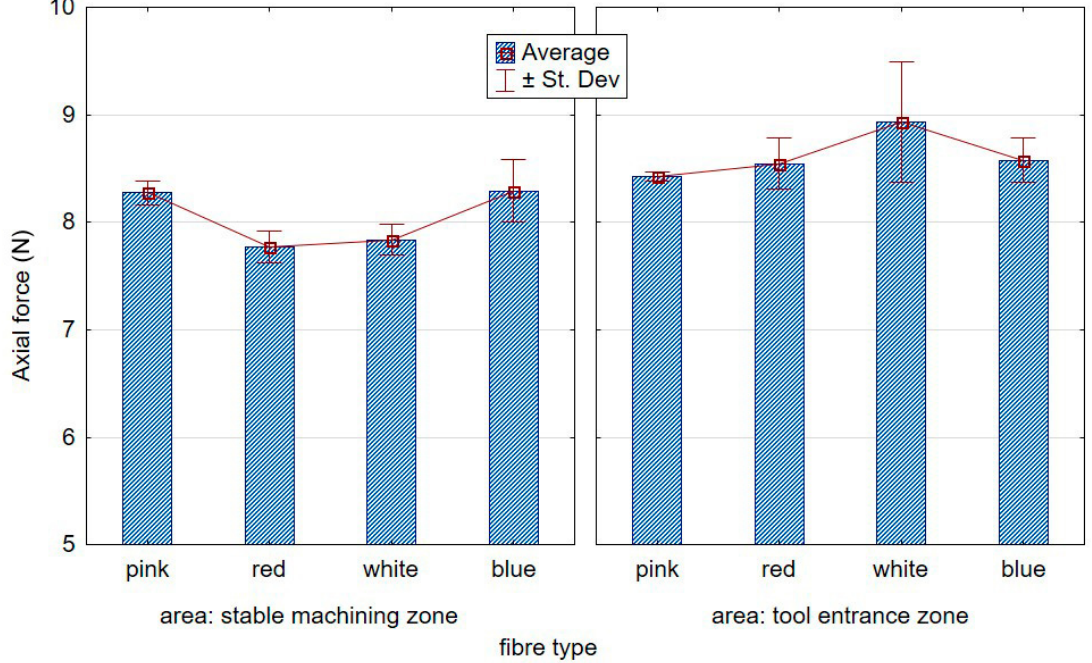
Figure 9. E ff ect of the fibre type on the axial forces at the tool entrance zone and the stable course for the “high” spring in the o ff set adjustment